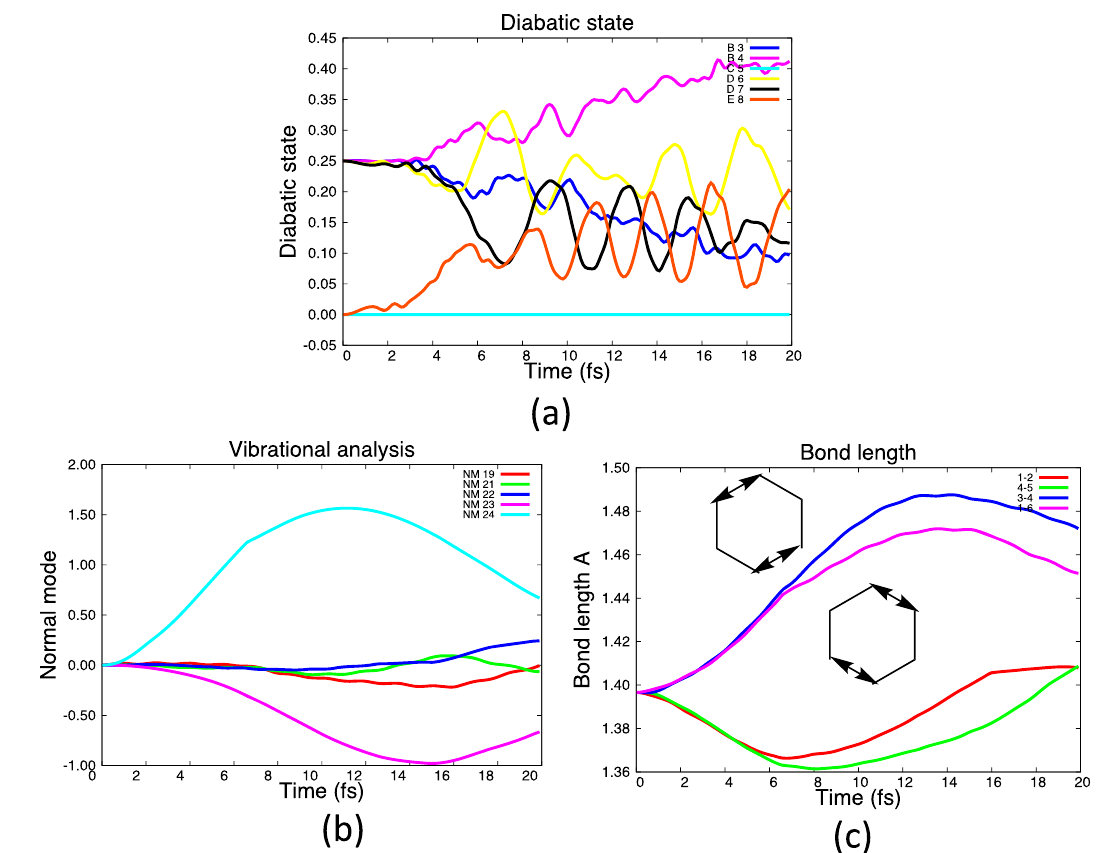
Fig. 8 Results of D + B, 4-state Qu – Eh dynamics. a Populations of diabatic states. b Normal mode displacements. c Bond vibrations for dominant